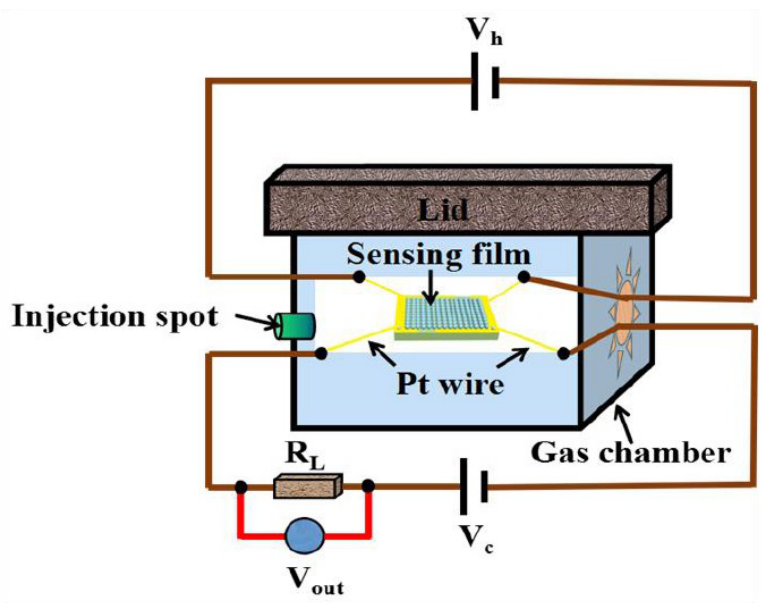
Figure 1. The gas sensitive testing system.